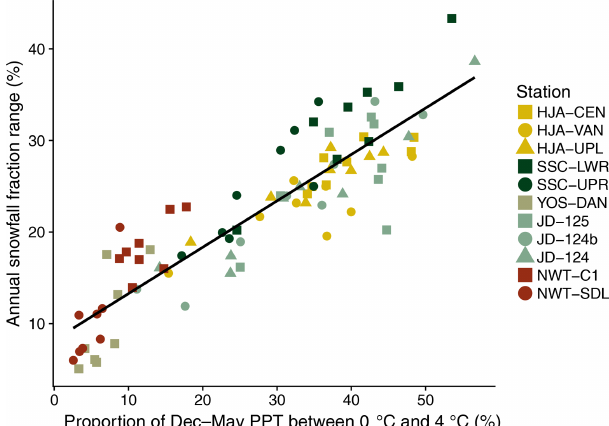
Figure 10. The standard deviation of daily snowfall fraction as a function of T a (a) and as a function of T a and RH (b) . We binned the meteorological quantities within the ranges shown and calcu- lated the standard deviation of snowfall fraction per T a bin (a) and T a / RH bin (b) using simulated precipitation phase from all stations and all methods.